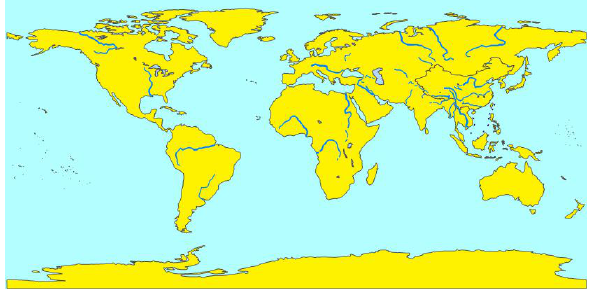
Figure 7. After Plate Generalization